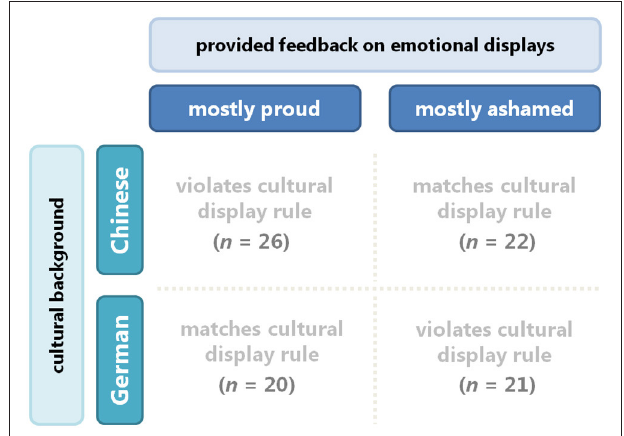
FIGURE 1 | The study’s between-subject design. Table cells contain each condition’s theoretical implications for cultural display